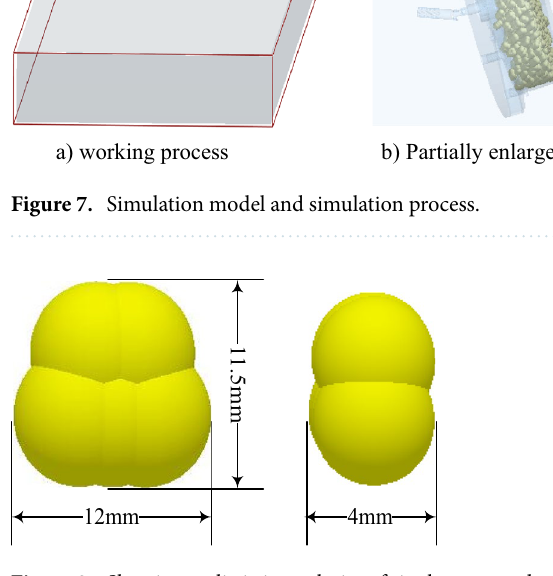
Figure 8. Showing realistic irregularity of single corn seed